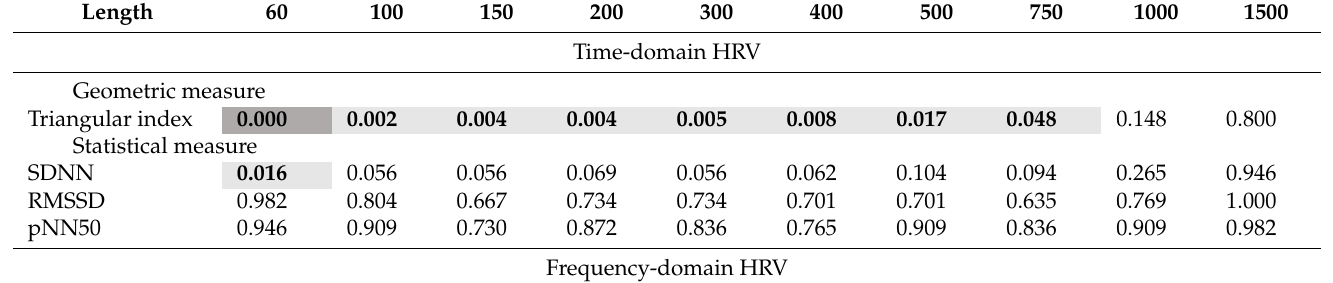
Table 2. Mann–Whitney U test results for comparing HRV measures at 2000 R peaks with shorter data lengths. Data length is in R peaks. Statistical significant differences ( p < 0.05) and statistical highly significant differences ( p < 0.001) are color labeled in lighter and darker gray with bold font,